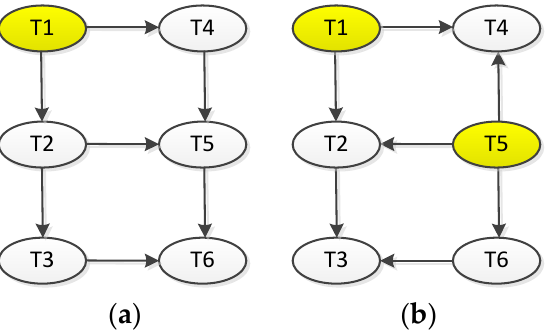
Figure 7. Non-optimal firefighting strategy for Scenario 3. ( a ) T1 and T5 are on fire. ( b ) T1 has been suppressed while T5 is on fire. ( c ) T1 has been suppressed, T5 is on fire, and T3 is cooled. Table 3. Tanks’ and terminal’s o ut-closeness scores for the graphs in Figures 6 and 7.